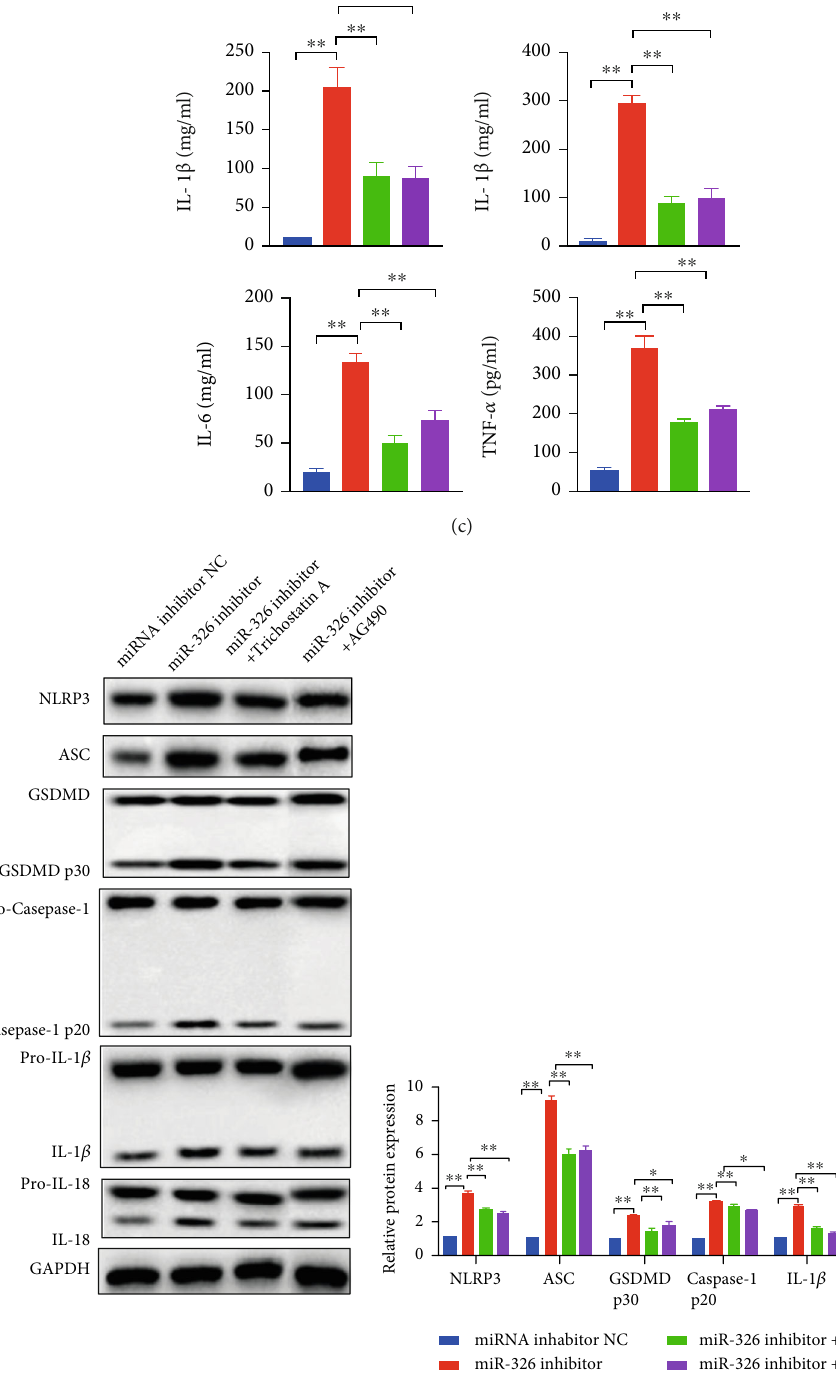
Figure 6: Inhibition of HDAC3 or STAT1/NF- κ B p65 signaling pathway counteracts pyroptosis induced by silence of miR-326 in chondrocytes. (a) Immuno fl uorescence results showed that inhibition of HDAC3 or STAT1/NF- κ B p65 could counteract the increase of GSDMD and cleaved Caspase-1 induced by miR-326 inhibitor in chondrocytes; (b) inhibition of HDAC3 or STAT1/NF- κ B p65 could counteract the increase of Caspase-1 activity induced by miR-326 inhibitor in chondrocytes; (c) inhibition of HDAC3 or STAT1/NF- κ B p65 could counteract the increase of proin fl ammatory factors (IL-1 β , IL-18, IL-6, and TNF- α ) induced by miR-326 inhibitor in chondrocytes; (d) Western blot results showed that inhibition of HDAC3 or STAT1/NF- κ B p65 could counteract the increase level of pyroptosis-related proteins (NLRP3, ASC, GSDMD, Caspase-1, IL-1 β , and IL-18) induced by miR-326 inhibitor in chondrocytes; ∗ P < 0 : 01 , ∗∗ P < 0 : 01